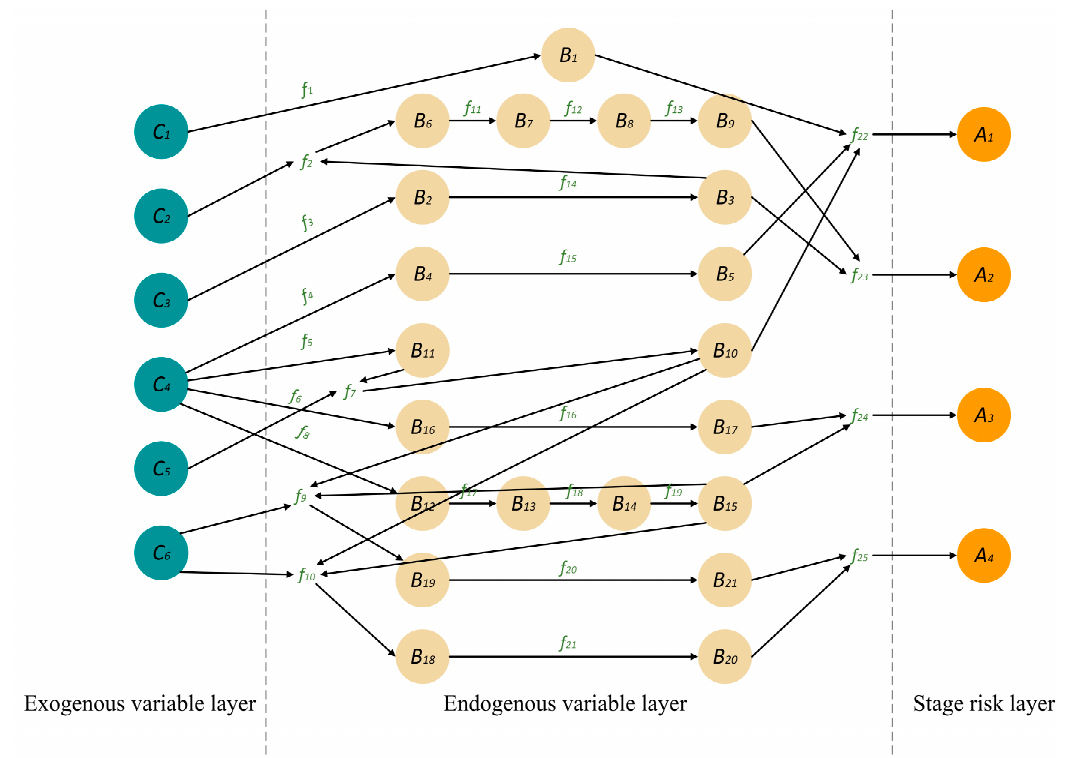
Figure 4. Causal diagram of risk factors for catenary construction.